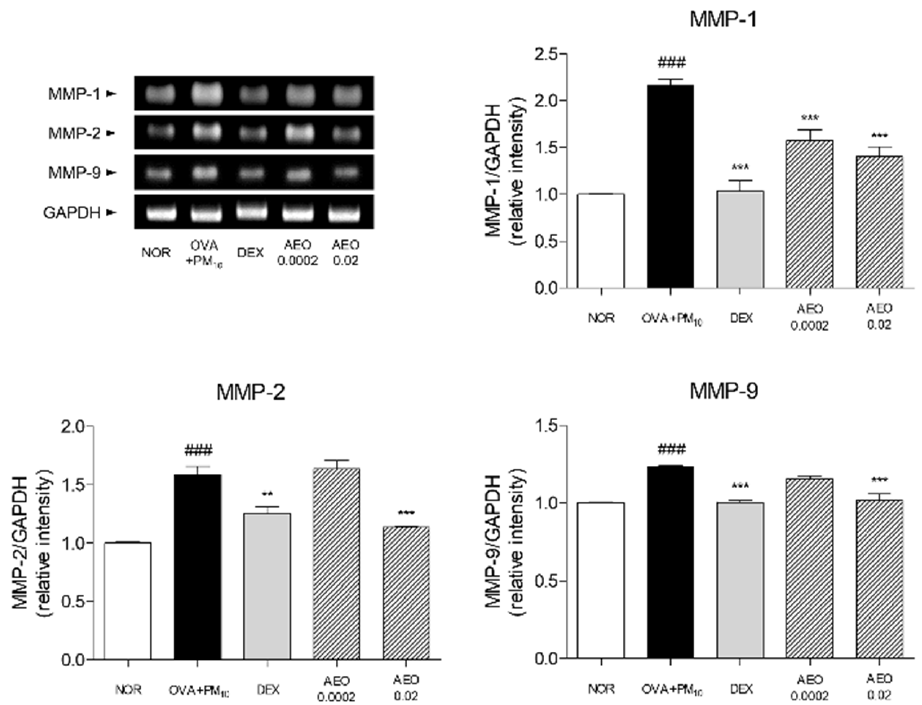
Figure 7. Expressions of MMPs, including MMP-1, -2 and -9, in lung tissues. Results are presented as mean ± standard error of the mean. ### p < 0.001 vs. NOR group; ** p < 0.01 and *** p < 0.001 vs. OVA+PM 10 group.